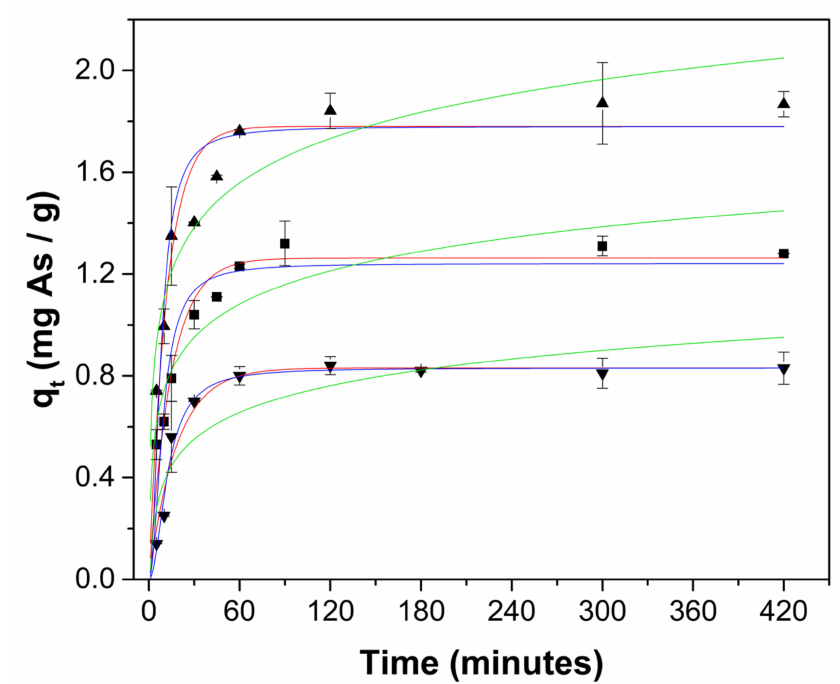
Figure 4. Experimental kinetic data of As adsorption onto ChM hydrogel beads at 25 ◦ C and initial pH = 7.0; using different initial concentrations: 5 mg As/L ( (cid:72) ), 10 mg As/L ( (cid:4) ) and ( (cid:78) ) 15 mg As/L. Uptake values predicted by pseudo-first order (—), pseudo-second order (—) and Elovich (—) models.